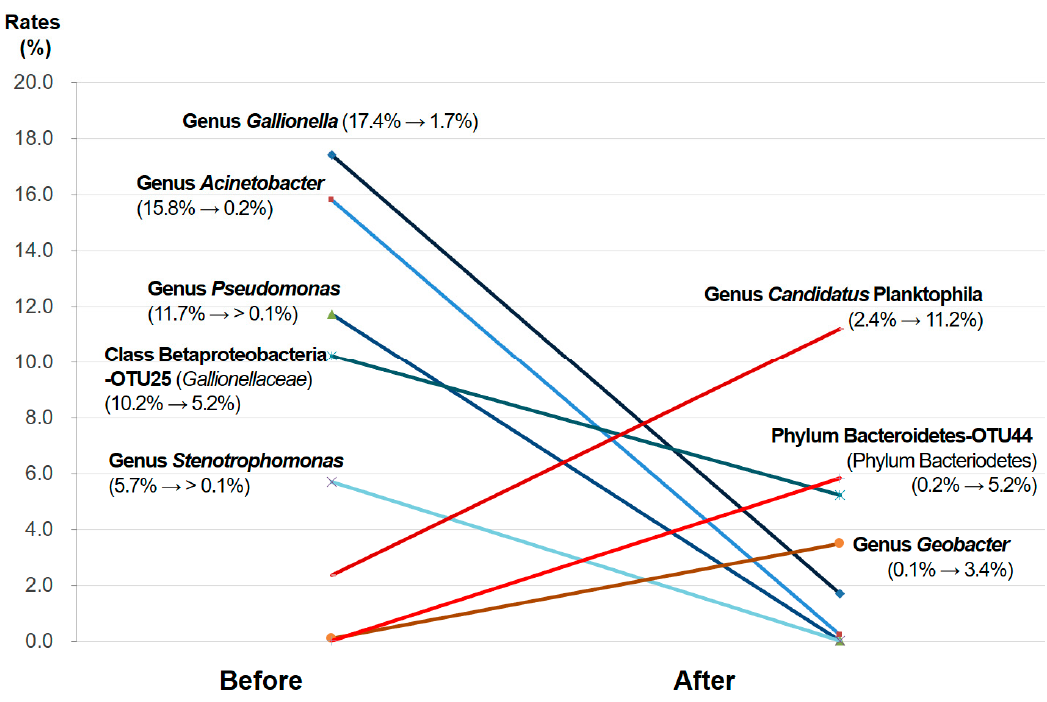
Figure 9. Comparison of major changes in genus or OTU level prevalence rates of taxa before and after air surging.